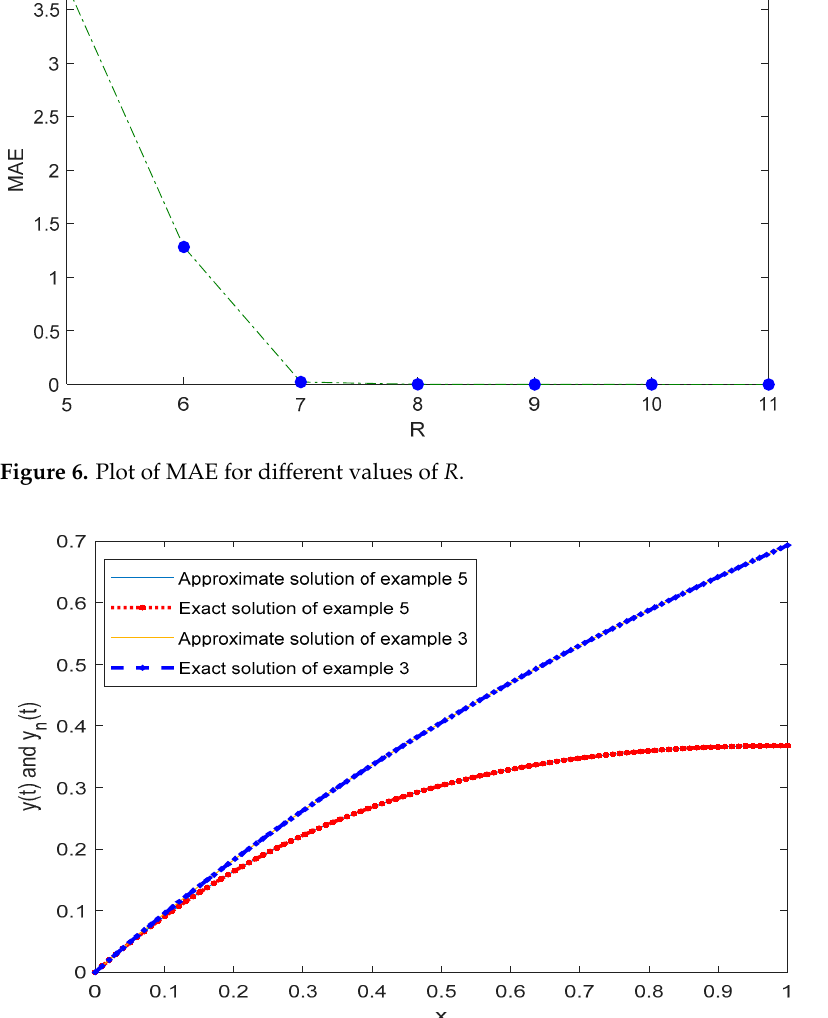
Figure 7. Plot of exact versus approximate solution of Examples 5 and 3 . Table 3. Comparision of MAEs for Example 3 with the method given in [29] for different values of 𝑅.